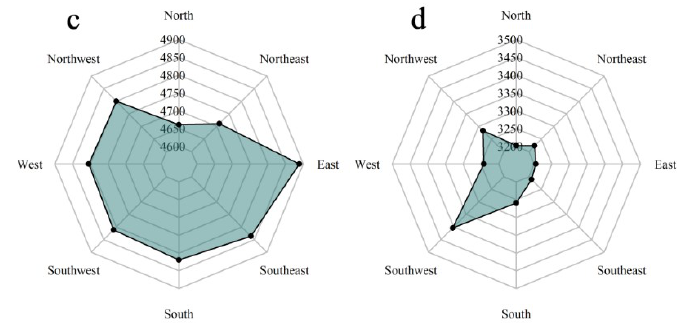
Figure 6. The distribution of the nearest alpine timberline points in different aspect directions: ( a ) number of nearest alpine timberline points; ( b ) average elevation of the nearest alpine timberline points; ( c ) highest elevation of the nearest alpine timberline points; ( d ) lowest elevation of the nearest alpine timberline points. The Southwest, Southeast, and South aspect denote sunny slopes, and Northwest, Northeast, and North aspect are the shady slopes.